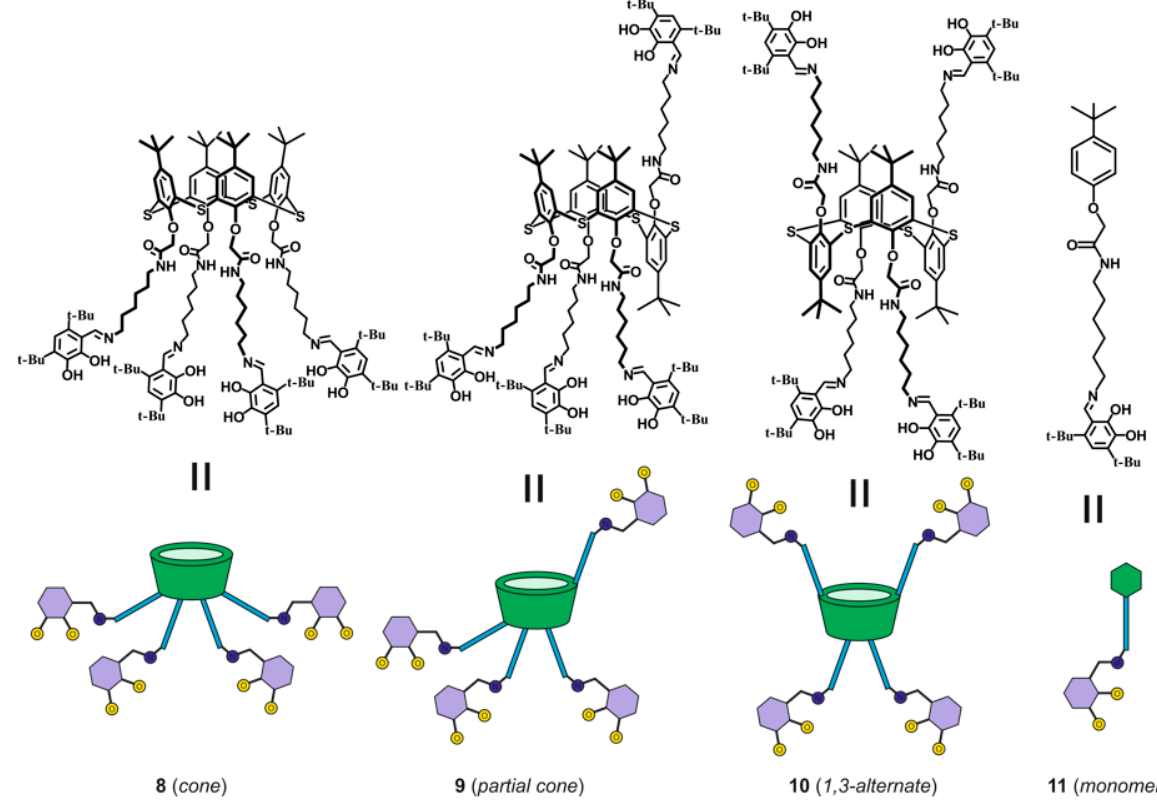
Figure 1. Structures and cartoon images of the compounds 8 – 11